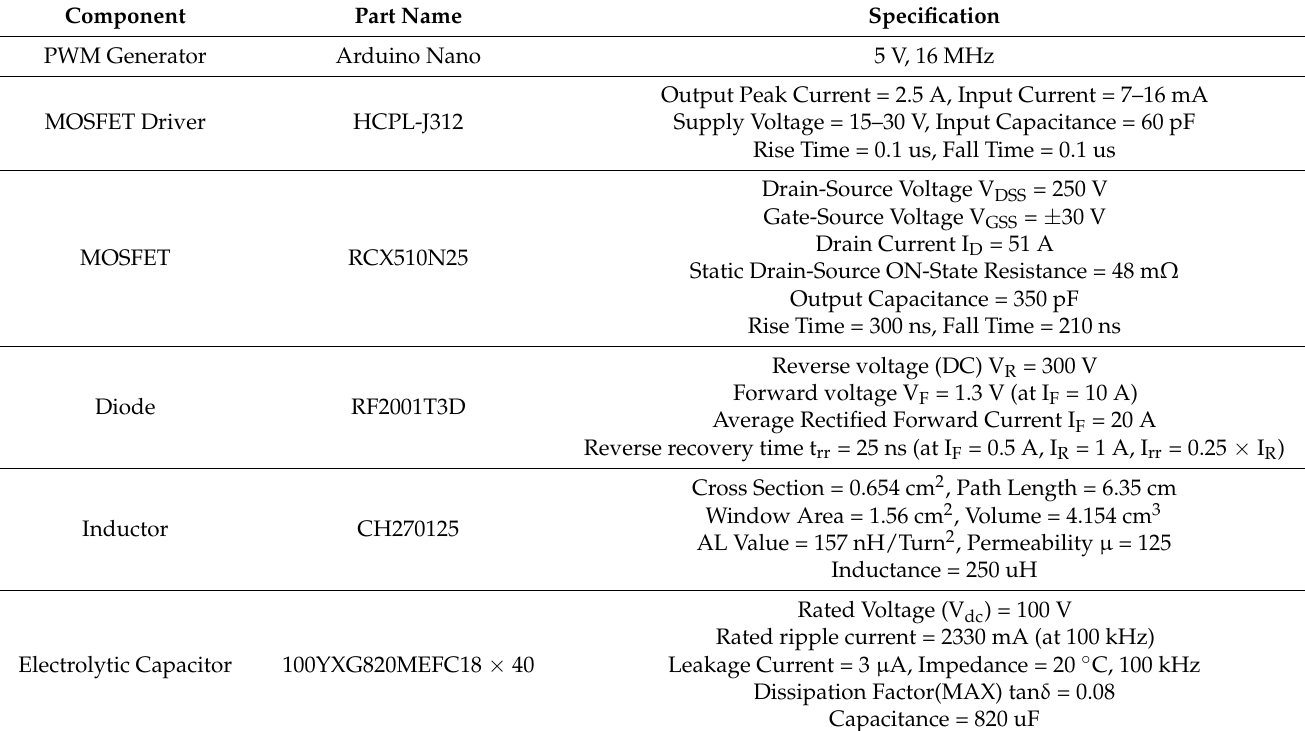
Figure 7. 100 W TSBB prototype. Table 7. Components specifications.